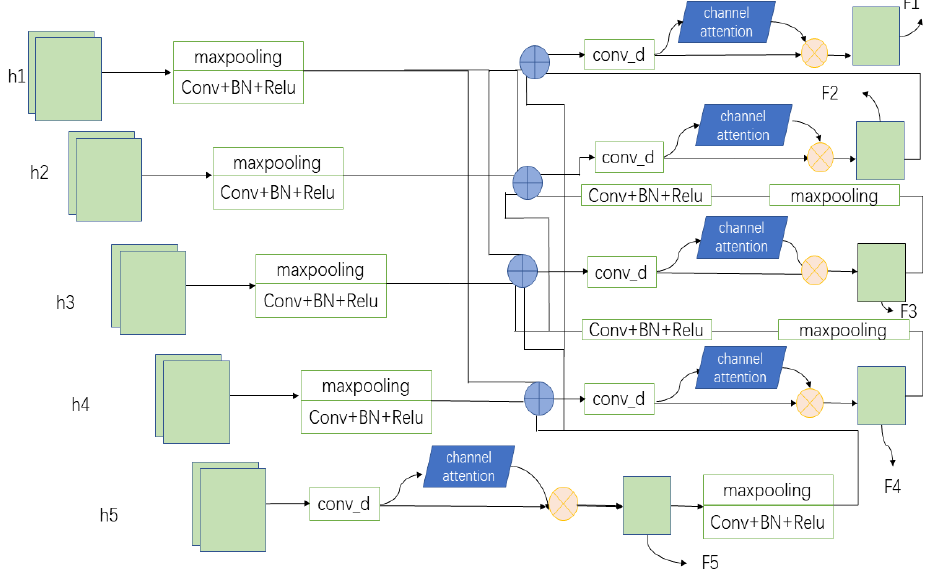
Figure 3. Structure of the MSCB.